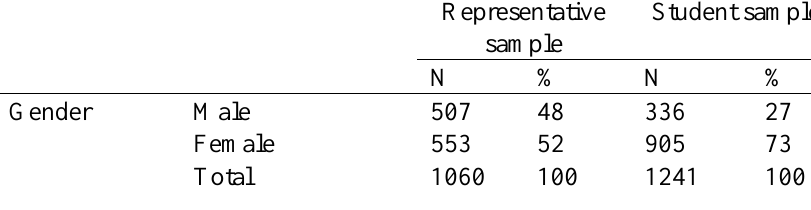
The Structure of the samples